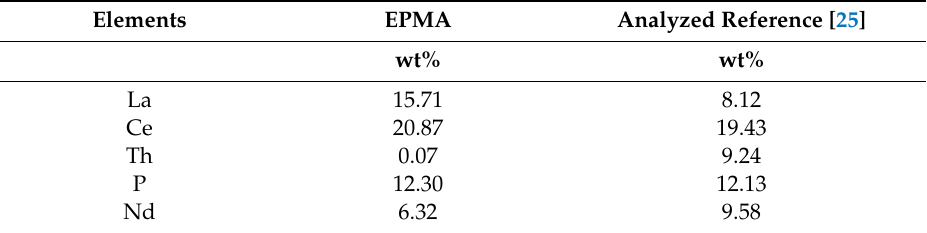
Table 2. Average composition of the monazite in the concentrate measured by electron microprobe analysis compared to the typical composition of a monazite standard reference [25].